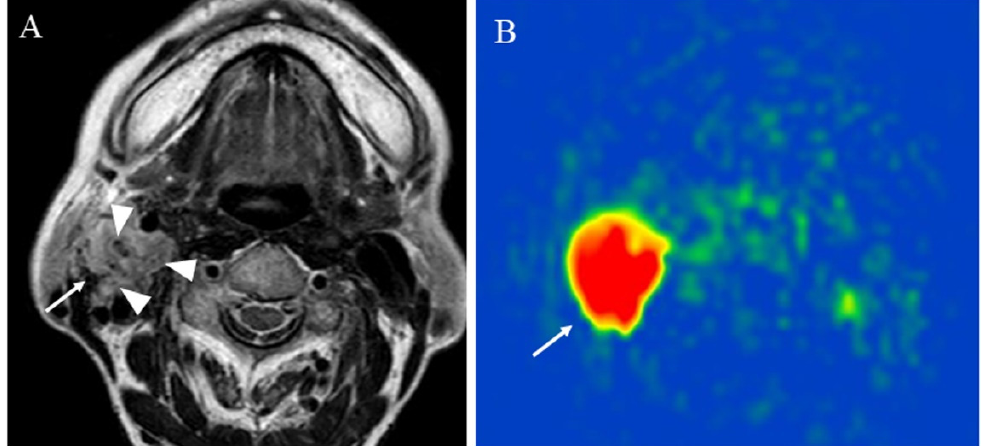
Figure 6. An 83-year-old female with the right carotid body paraganglioma: ( A ) T2-weighted image shows a right cervical mass (arrow) at the carotid artery bifurcation with high signal intensity and flow voids or salt and pepper appearance within the mass (arrowhead); ( B ) pCASL image shows abundant blood flow within the lesion (arrow) (mean of 303.04 mL/100 g/min).